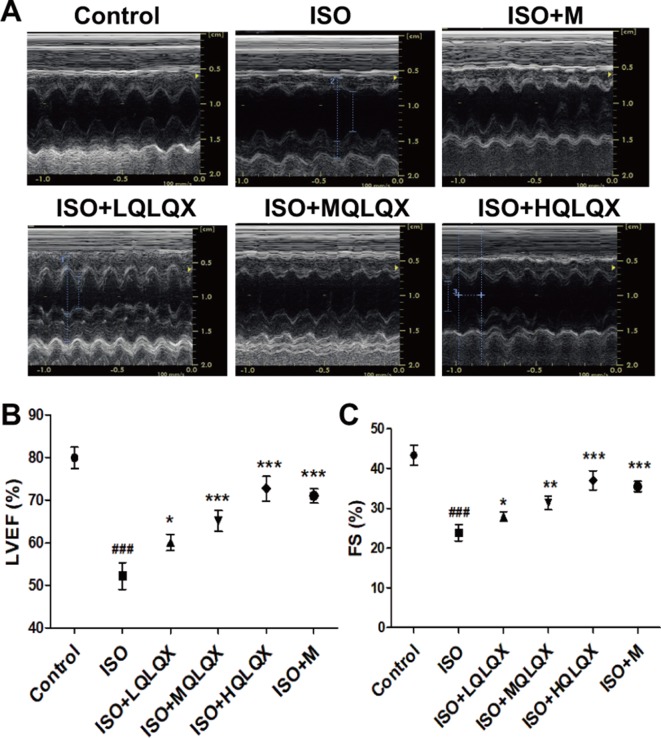
QLQX treatment ameliorates cardiac function in the rats of CHF induced by ISO. (A) Representative M mode images of echocardiography for the different groups. (B, C) Quantitative analysis of cardiac function by echocardiography measurement: LVEF (B), FS (C). Data are expressed as mean ± SD, n = 8. ###
p < 0.001 versus control group; *p < 0.05, **p < 0.01, ***p < 0.001 versus ISO group. CHF, chronic heart failure; LVEF, left ventricular ejection fraction; QLQX, Qi-Li-Qiang-Xin, ISO, isoproterenol.